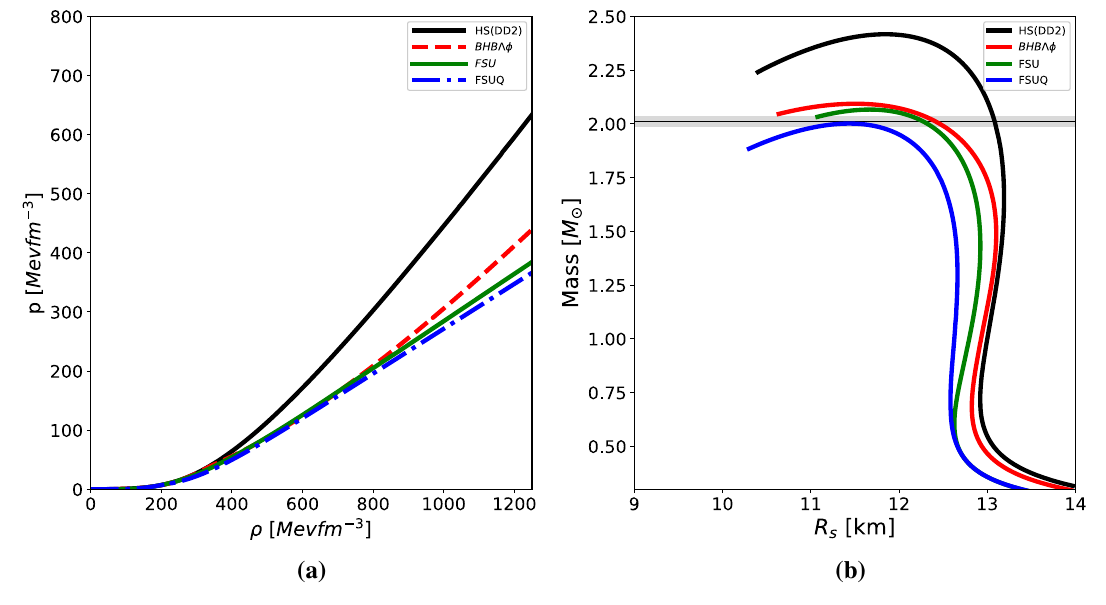
Fig. 1 a Pressure vs energy density curve of the EoS under study. b GR MR curves of EoS Table 1 Maximum mass and corresponding radius of the NS for a = 0 (GR); a = 50 for non-perturbative (NP) f ( R ) and a = 0.2 for